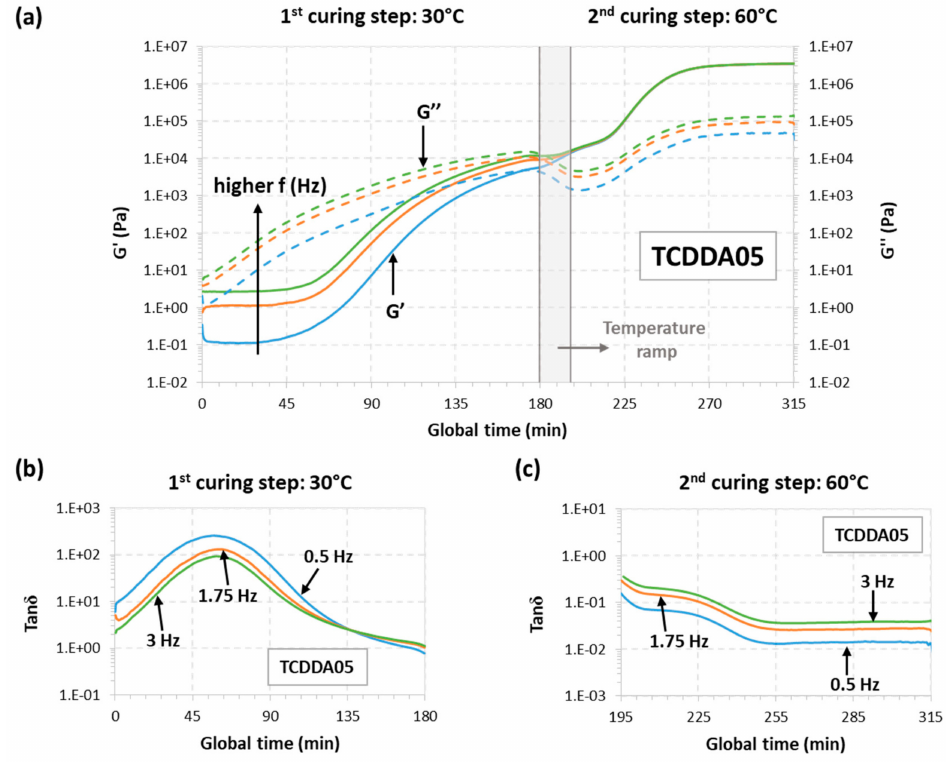
Figure 3. Rheological analysis of TCDDA05 dual-curing procedure: ( a ) Storage modulus ( G (cid:48) ) and loss modulus ( G ”) evolution with time during the whole dual-curing process; ( b ) evolution of tan δ with time during the 1st curing stage and ( c ) evolution of tan δ during the 2nd curing